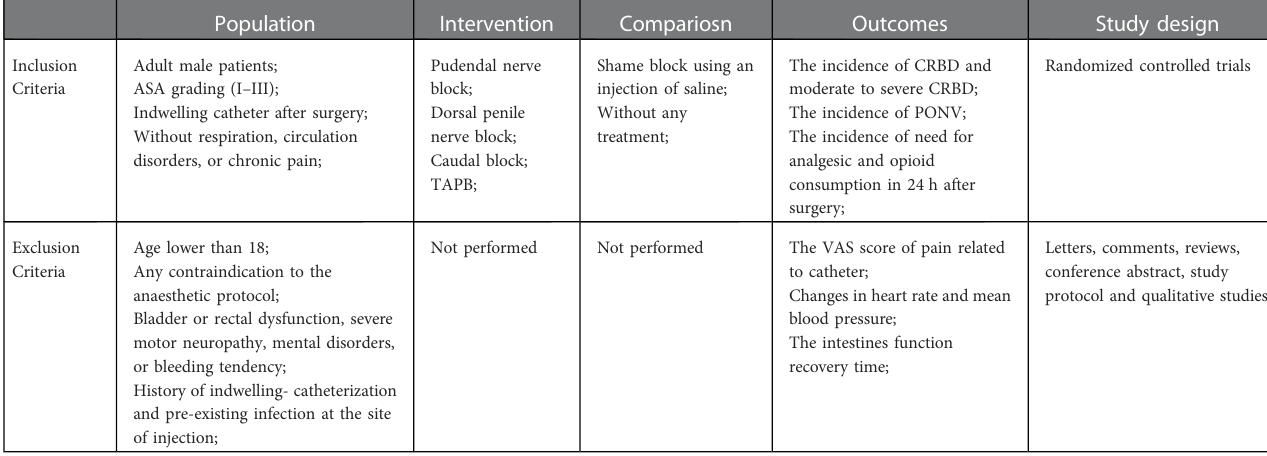
TABLE 1 Search strategy according to population, intervention, comparison, outcome, and study design. Population Intervention Compariosn